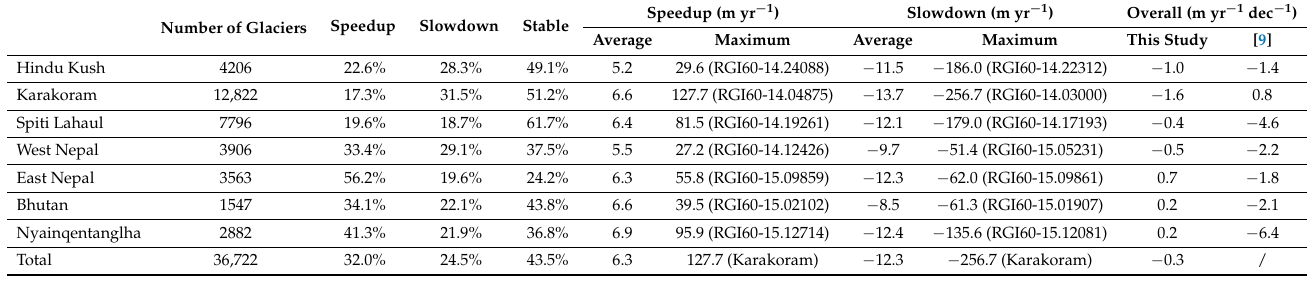
Table 1. Statistics of glacier velocity changes in the Himalayas. Stable glaciers are defined as the amplitude of differences between Landsat-7 and Sentinel-2 velocities, i.e., velocity changes between 1999 and 2018, ≤ 3 m yr − 1 . Velocity changes > 3 m yr − 1 are regarded as speedup and < − 3 m yr − 1 as slowdown. The overall changes were calculated by averaging all the glaciers within each subregion, in order to be comparable with the results in [9].